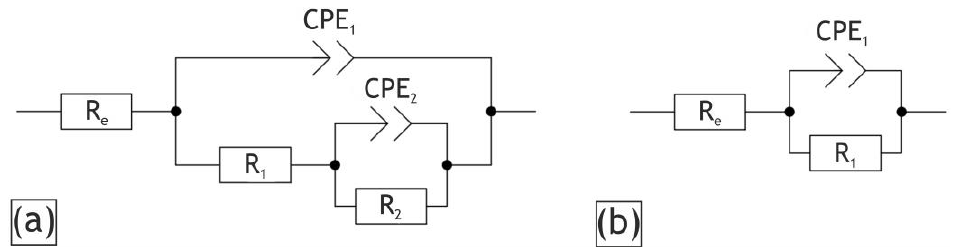
Figure 12. Equivalent electrical circuits used for fitting the impedance spectra.